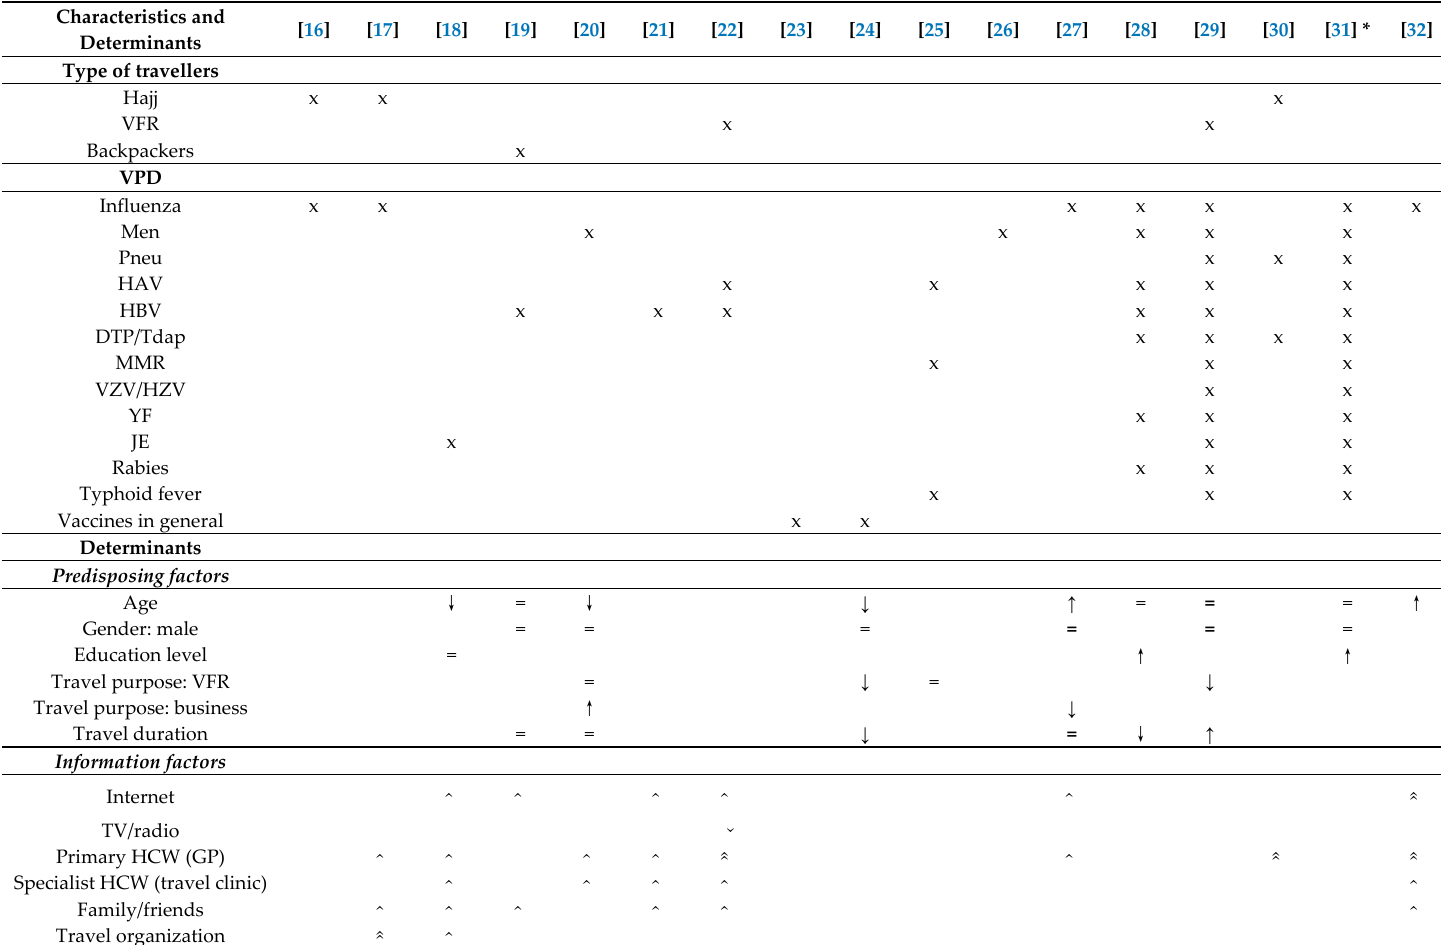
Table 2. Overview of determinants of vaccination uptake in travellers.